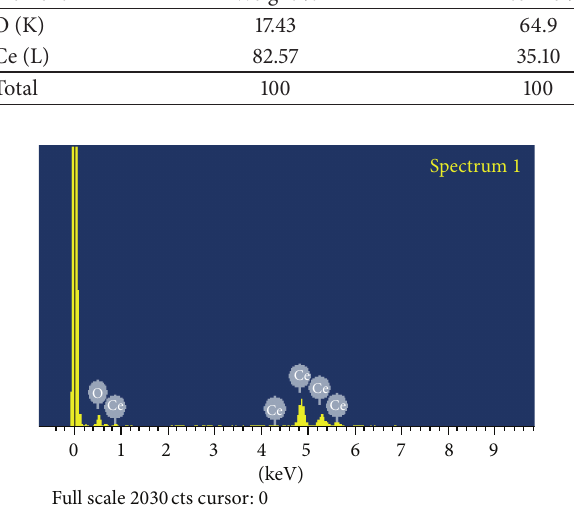
Figure 1: EDS spectrum of CeO 2